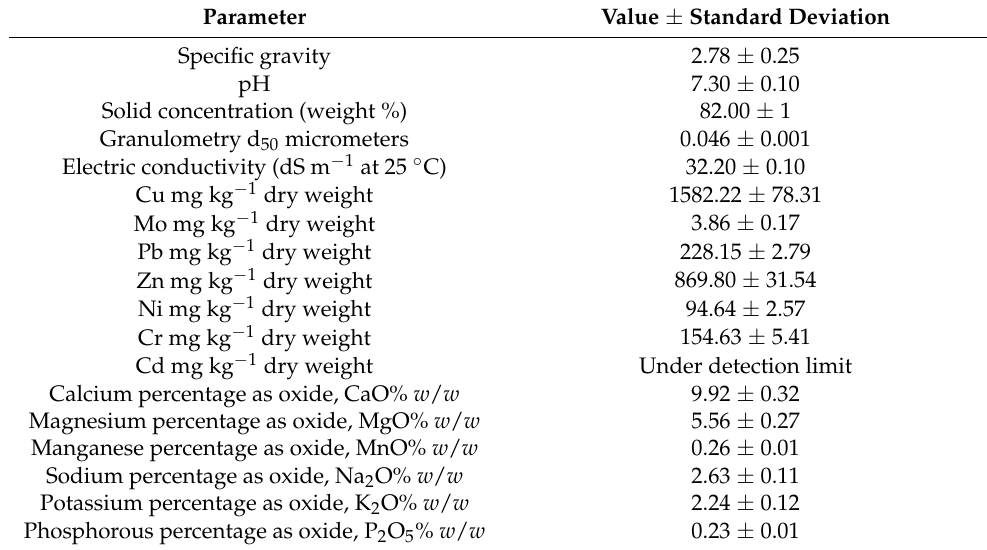
Table 1. pH value, granulometric composition, and composition of the